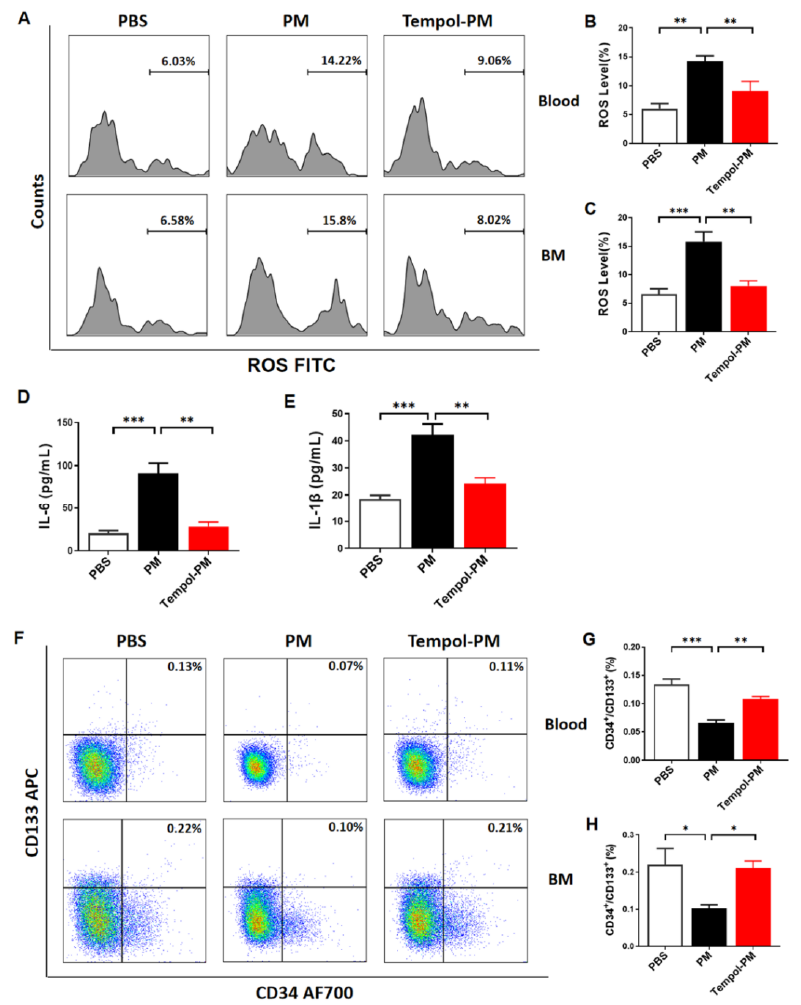
Figure 3. Tempol treatment preserved the EPCs in male mice with PM exposure . ( A ) Flow cytome- try analysis was used to determine the ROS level in CD34 + /CD133 + cells, with summary data showing that increased ROS production exposed to PM was blocked by Tempol treatment in the blood ( B ) and bone marrow ( C ). Elevated serum levels of pro-inflammatory cytokines IL-6 ( D ) and IL-1β ( E ) induced by PM were effectively prevented by Tempol treatment. ( F ) Flow cytometry analysis for circulating EPCs (CD34 + /CD133 + ), with summary data showing that the PM exposure-induced decrease in the circulating EPC level in male mice was restored after Tempol treatment in the blood ( G ) and bone marrow ( H ). n = 5. PBS: male mice with PBS treatment; PM: male mice with PM expo- sure; Tempol-PM: male mice with PM exposure and Tempol treatment. BM: bone marrow. * p < 0.05, ** p < 0.01, and *** p < 0.001.